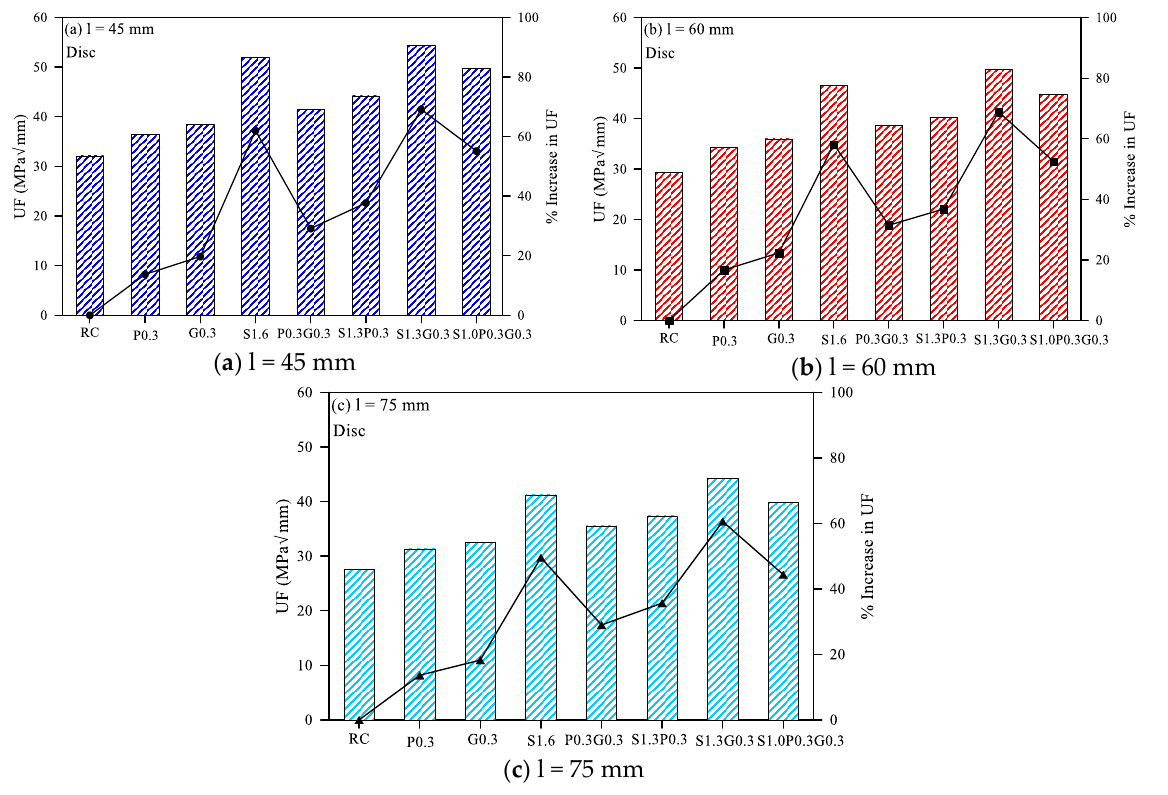
Figure 2. Mode II disc specimens’ fracture energy of the eight geopolymer mixtures. Table 4. Fracture toughness test